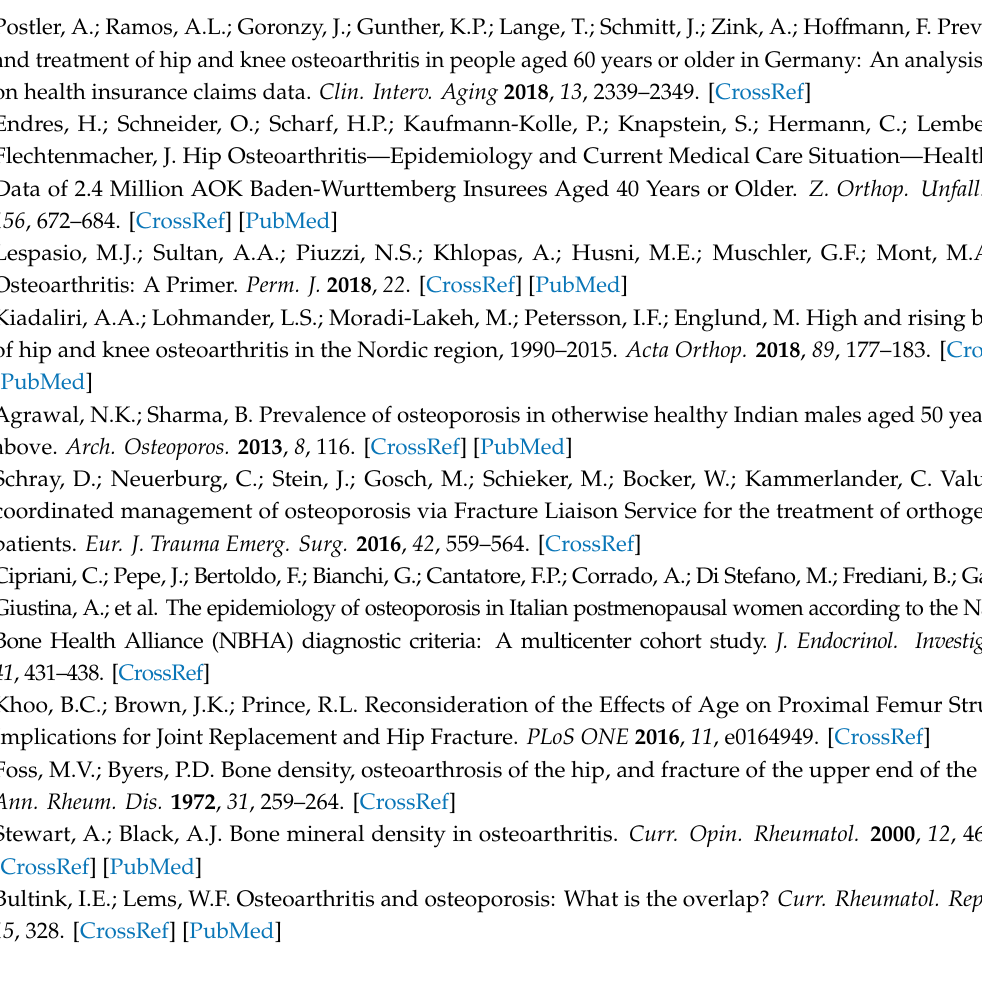
Table S1: Patients’ baseline characteristics. Mean values of selected morphometric and densitometric characteristics in BMD-based groups, Table S2: Results ( p -values) of U Mann-Whitney test comparing di ff erent densitometric groups with regard to presence of radiographic signs of hip